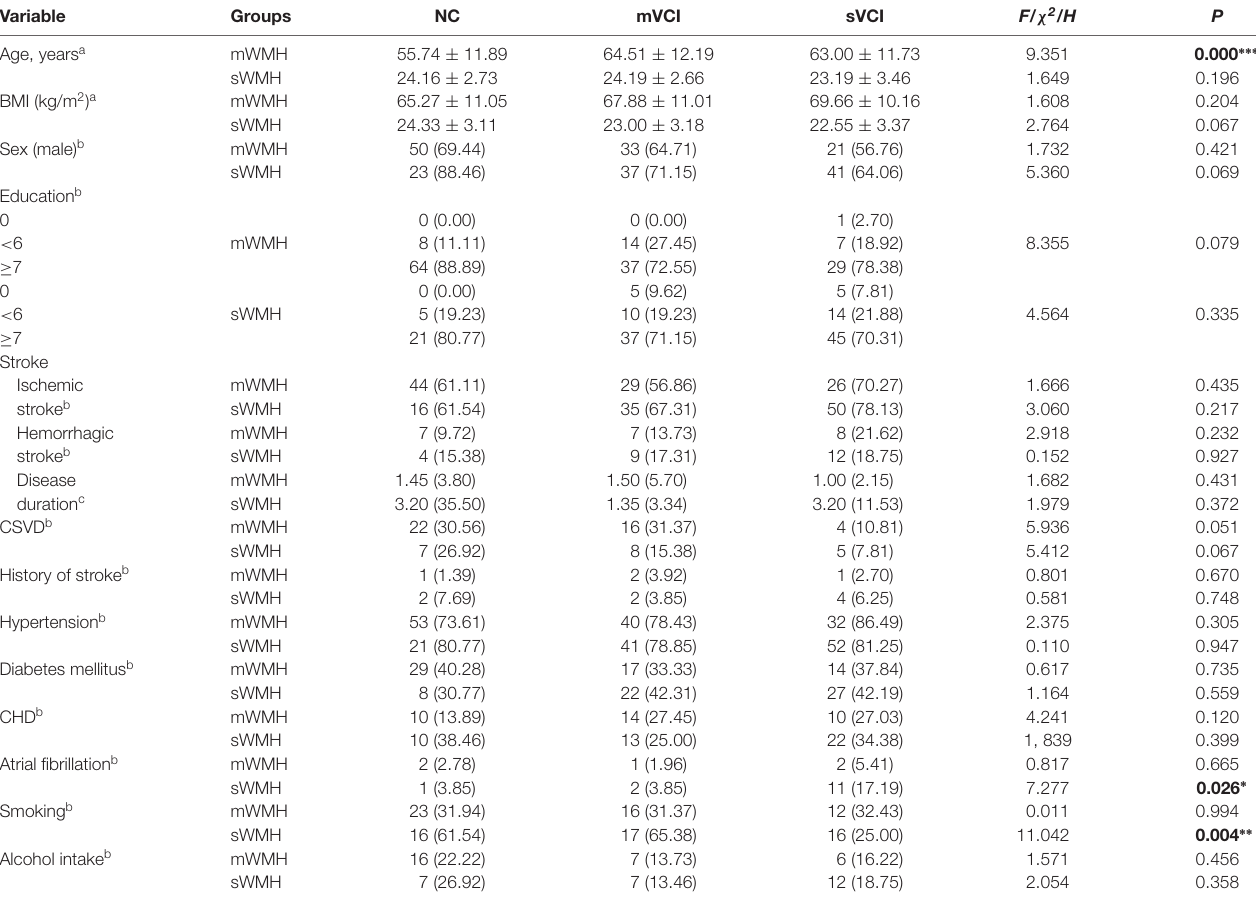
TABLE 1 | Basic demographic data of the mWMH and sWMH groups with different cognitive levels. Variable Groups NC mVCI sVCI F/ χ 2